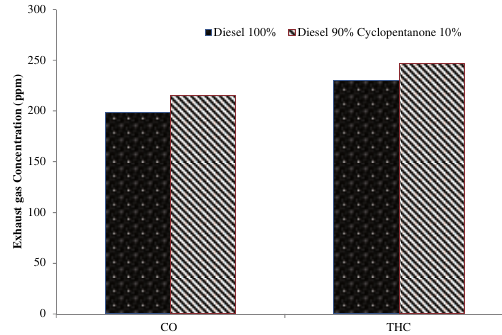
Fig. 10. Engine exhaust NO x species concentration for each tested fuels Fig. 8. Exhaust CO and THC species measured for each tested fuels health. Bio-ketones which are produced from lignocellulose 1.522.533.544.5 biomass are one of the new alternative fuels to use in the current engine without any modifications. Results show that ketone blends have proper fuel properties to use in the die- sel engine without use of any additives or lubricant. This blend had slightly longer ignition delay than diesel because of carbonyl groups which make H-abstraction more diffi- cult from ketone compared to diesel (Alkanes) [20]. NO emissions from combustion of this fuel is slightly lower that 00.51 diesel fuel which make this fuel more interesting for further investigation. Increase of other gaseous emissions requires some more studies based on use of after treatment strategies in various engine conditions. From the literature, due to the Fig. 9. Engine exhaust hydrocarbon species measured for each tested fuels presence of oxygen content in carbonyl groups a reduction in particulate mass can be expected; this will be studied in Uses of appropriate Diesel Oxidation Catalysts, Selec- the future by using Scanning Mobility Particle Sizer Spec- tive Catalytic Reduction and NO absorber catalyst were x suggested for further investigation in different engine ex- periment conditions.